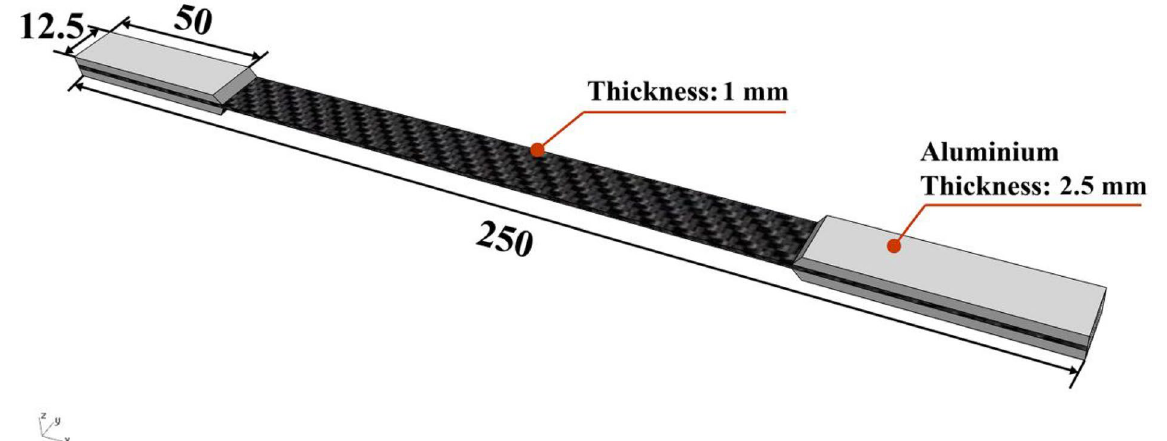
Fig. 2 Dimension of the HFRP tensile specimens (unit: